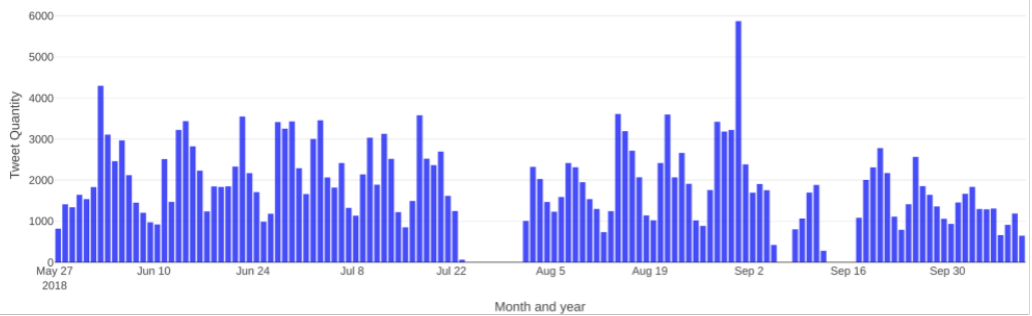
Figure 1. A timeline of the collected Twitter data from 27 May 2018 to 10 October 2018. Missing data indicate technical